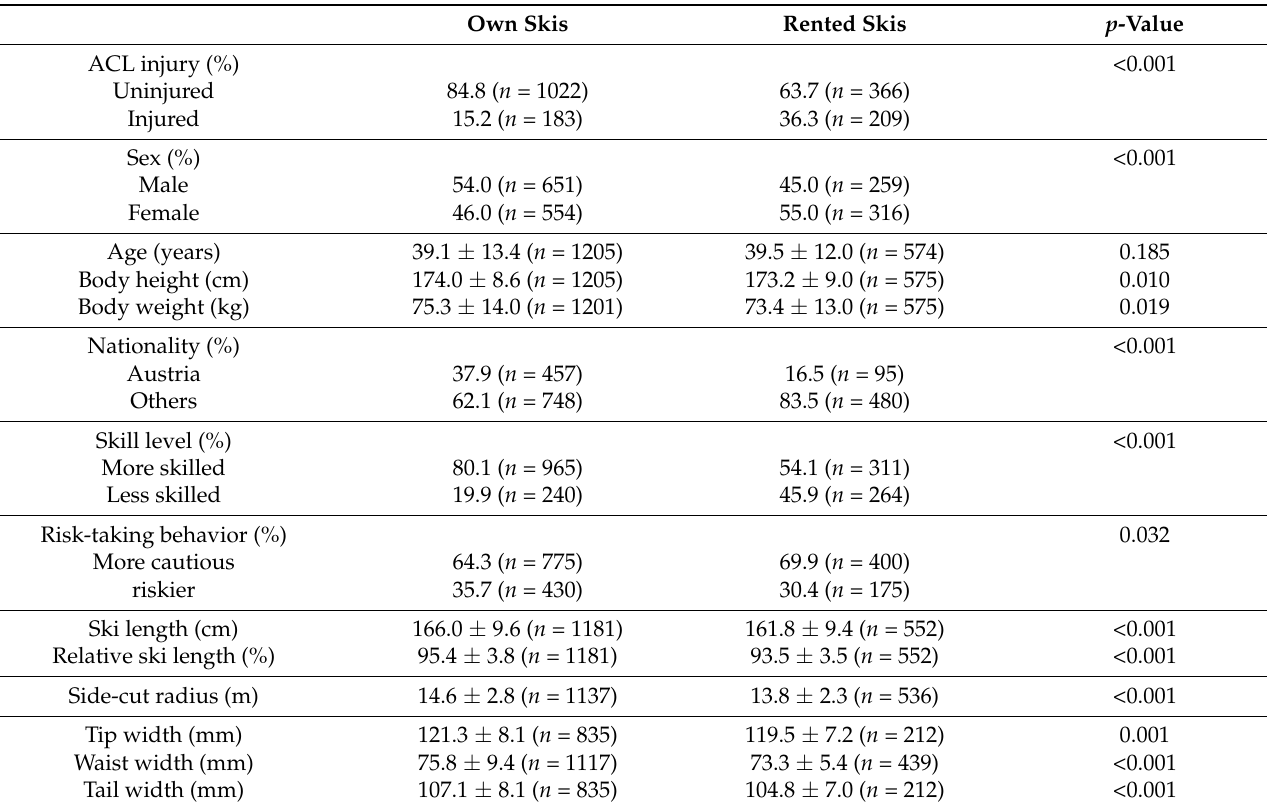
Table 1. Univariate comparison of individual and ski-geometry-related risk factors between skiers with own skis and with rented